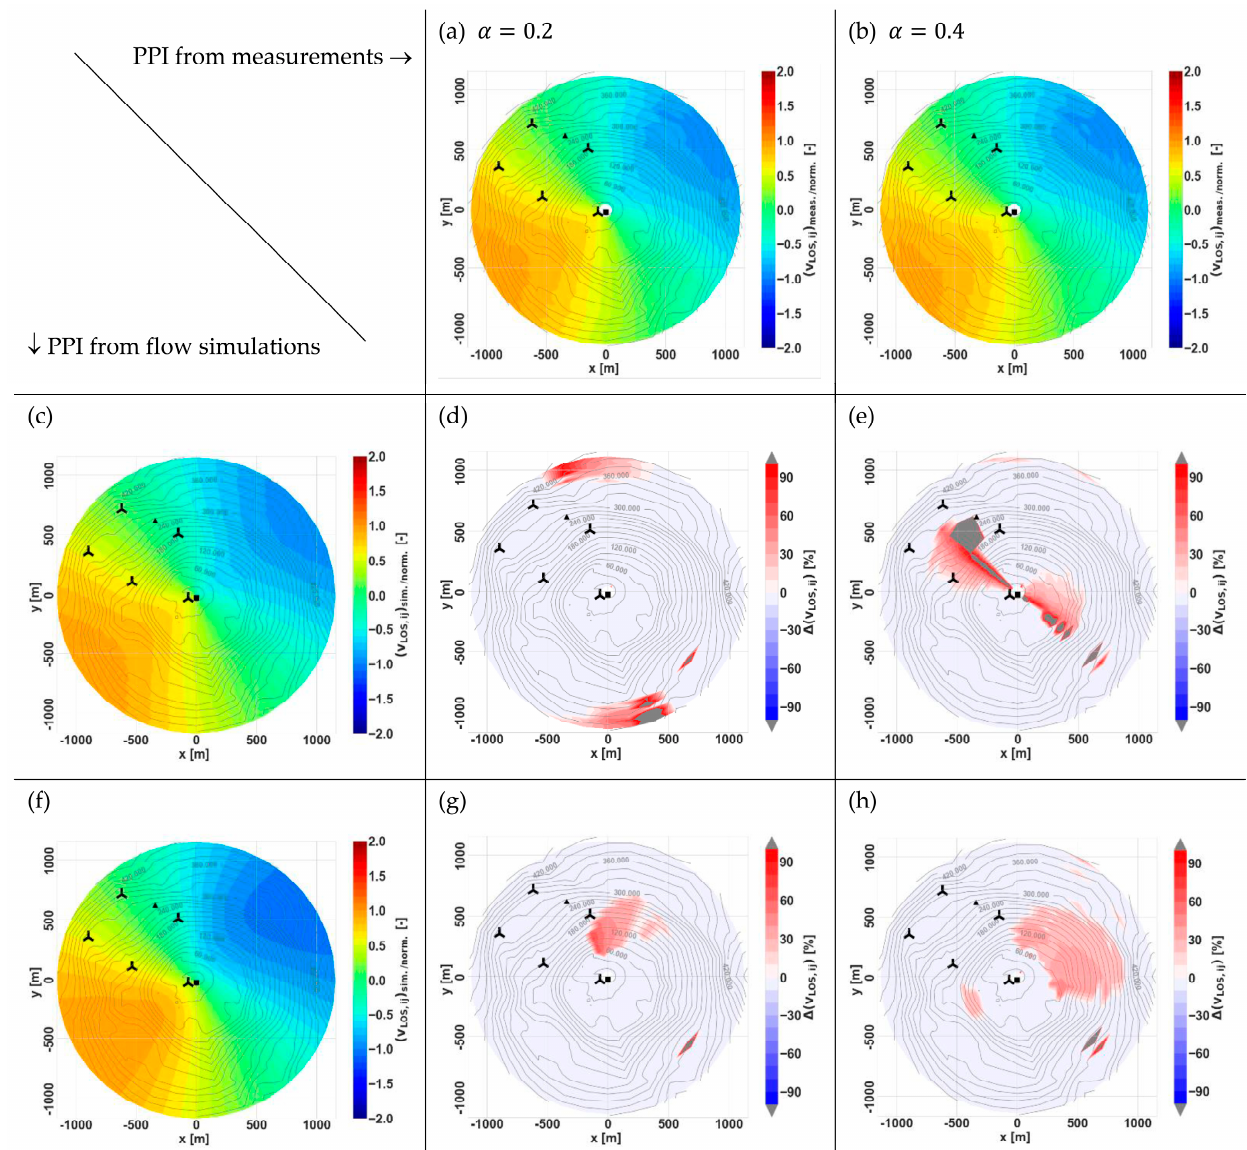
Figure 7. Measured and simulated PPI patterns, as well as corresponding deviations, for the averaged flow cases with 𝜑 = 240° and 𝛼 = 0.2 (middle column) and 𝛼 = 0.4 (right column), respectively—( a , b ) (𝑣 (cid:3013)(cid:3016)(cid:3020),(cid:3036)(cid:3037) ) (cid:3040)(cid:3032)(cid:3028)(cid:3046)./(cid:3041)(cid:3042)(cid:3045)(cid:3040). from scanning lidar measurements, ( c , f ) (𝑣 (cid:3013)(cid:3016)(cid:3020),(cid:3036)(cid:3037) ) (cid:3046)(cid:3036)(cid:3040)./(cid:3041)(cid:3042)(cid:3045)(cid:3040). from numerical simulations with FIWind and FITNAH, respectively, ( d , e ), ( g , h ) the corresponding deviations ( ∆𝑣 (cid:3013)(cid:3016)(cid:3020),(cid:3036)(cid:3037) ) . Measurements for 𝛼 = 0.2 𝑎𝑛𝑑 0.4 𝑤𝑒𝑟𝑒 averaged from 140 and 105 individual flow situations, respectively.